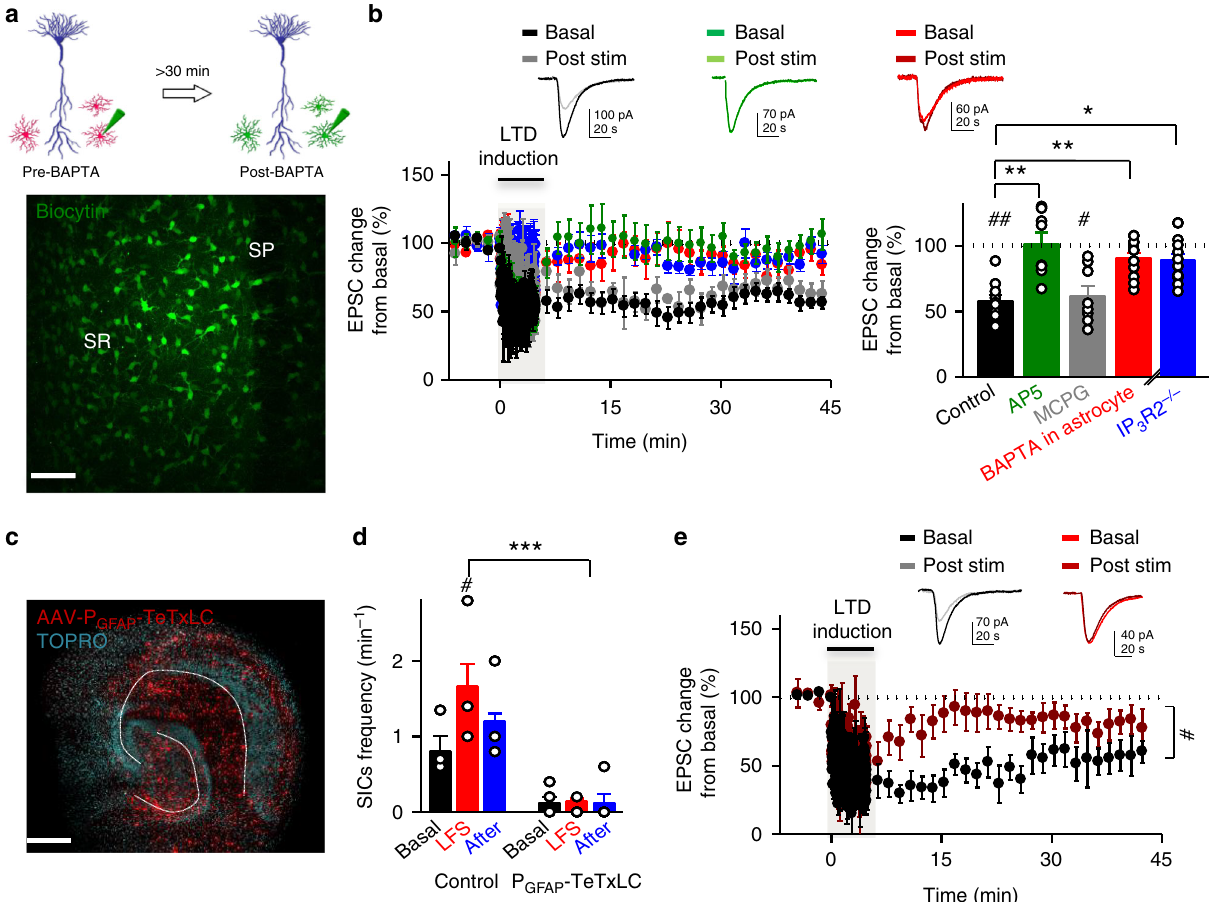
Fig. 2 NMDA receptor-dependent LTD requires astrocyte activity. a Schematic drawing depicting BAPTA dialysis into the astrocytic network from the recorded acute hippocampal slice. BAPTA and biocytin-loaded astrocytes were confocally imaged. Scale bar, 50 μ m. b (Inset) Representative EPSCs before and 30 min after LFS in acute hippocampal slices. Relative EPSC amplitudes (left) and average relative changes (right) versus time during an LTD experiment with control slices (black, n = 10), incubated with AP5 (green, n = 8), or MCPG (gray, n = 8), with BAPTA-loaded astrocytes (red, n = 12)